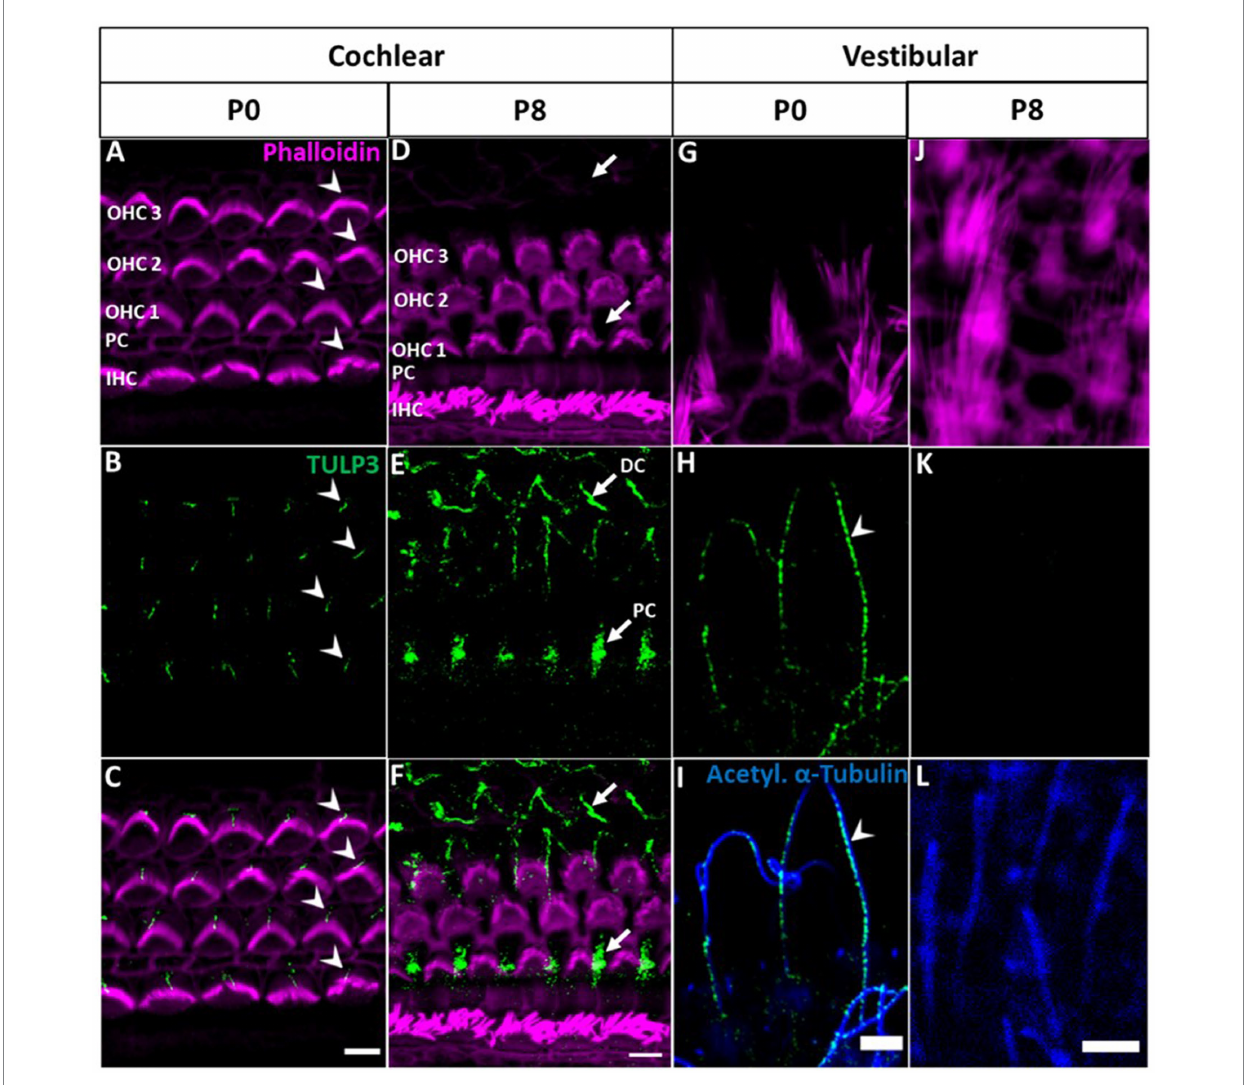
FIGURE 3 TULP3 immunoreactivity in the cochlear and vestibular epithelium of newborn mice compared with P8 mice. (A – L) P0 and P8 whole-mount immunohistochemical staining of TULP3 (green), Phalloidin (staining actin, magenta) and acetylated α -tubulin (blue) in the mouse organ of corti (A – F) and the vestibular epithelium (G – L) . (A – C) TULP3 immunoreactivity is present in cochlear hair cell kinocilia of IHCs and OHCs (arrowhead). (D – F) At P8, TULP3 is absent in kinocilia, but localized to the microtubule bundles of Deiters‘cells (DC) and pillar cells (PC) (arrows). (G – L) In the vestibular epithelium, TULP3 immunoreactivity is present in hair cell kinocilia at P0 (arrowhead) but absent at P8. Scale Bar 5 μ